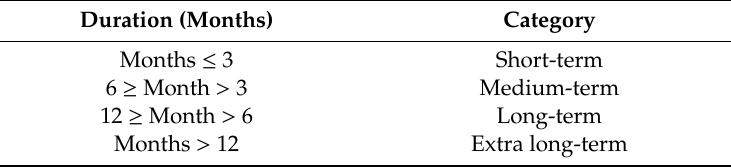
Table 3. Drought classification based on drought